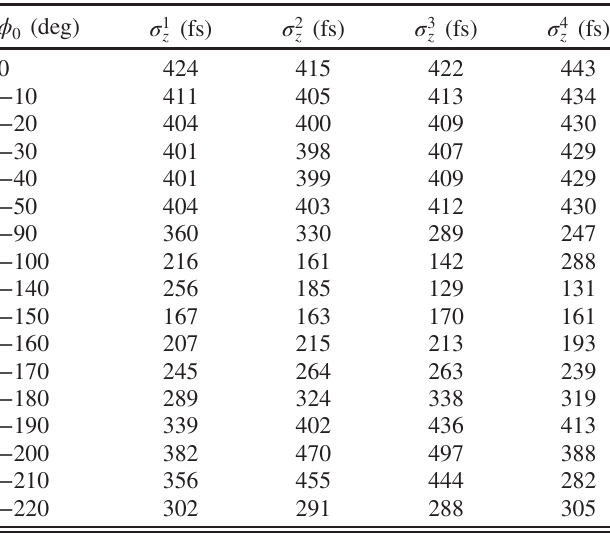
TABLE II. Bunch lengths (rms) of subbunches in a 4 × 20 pC bunch train with different injected phases ϕ 0